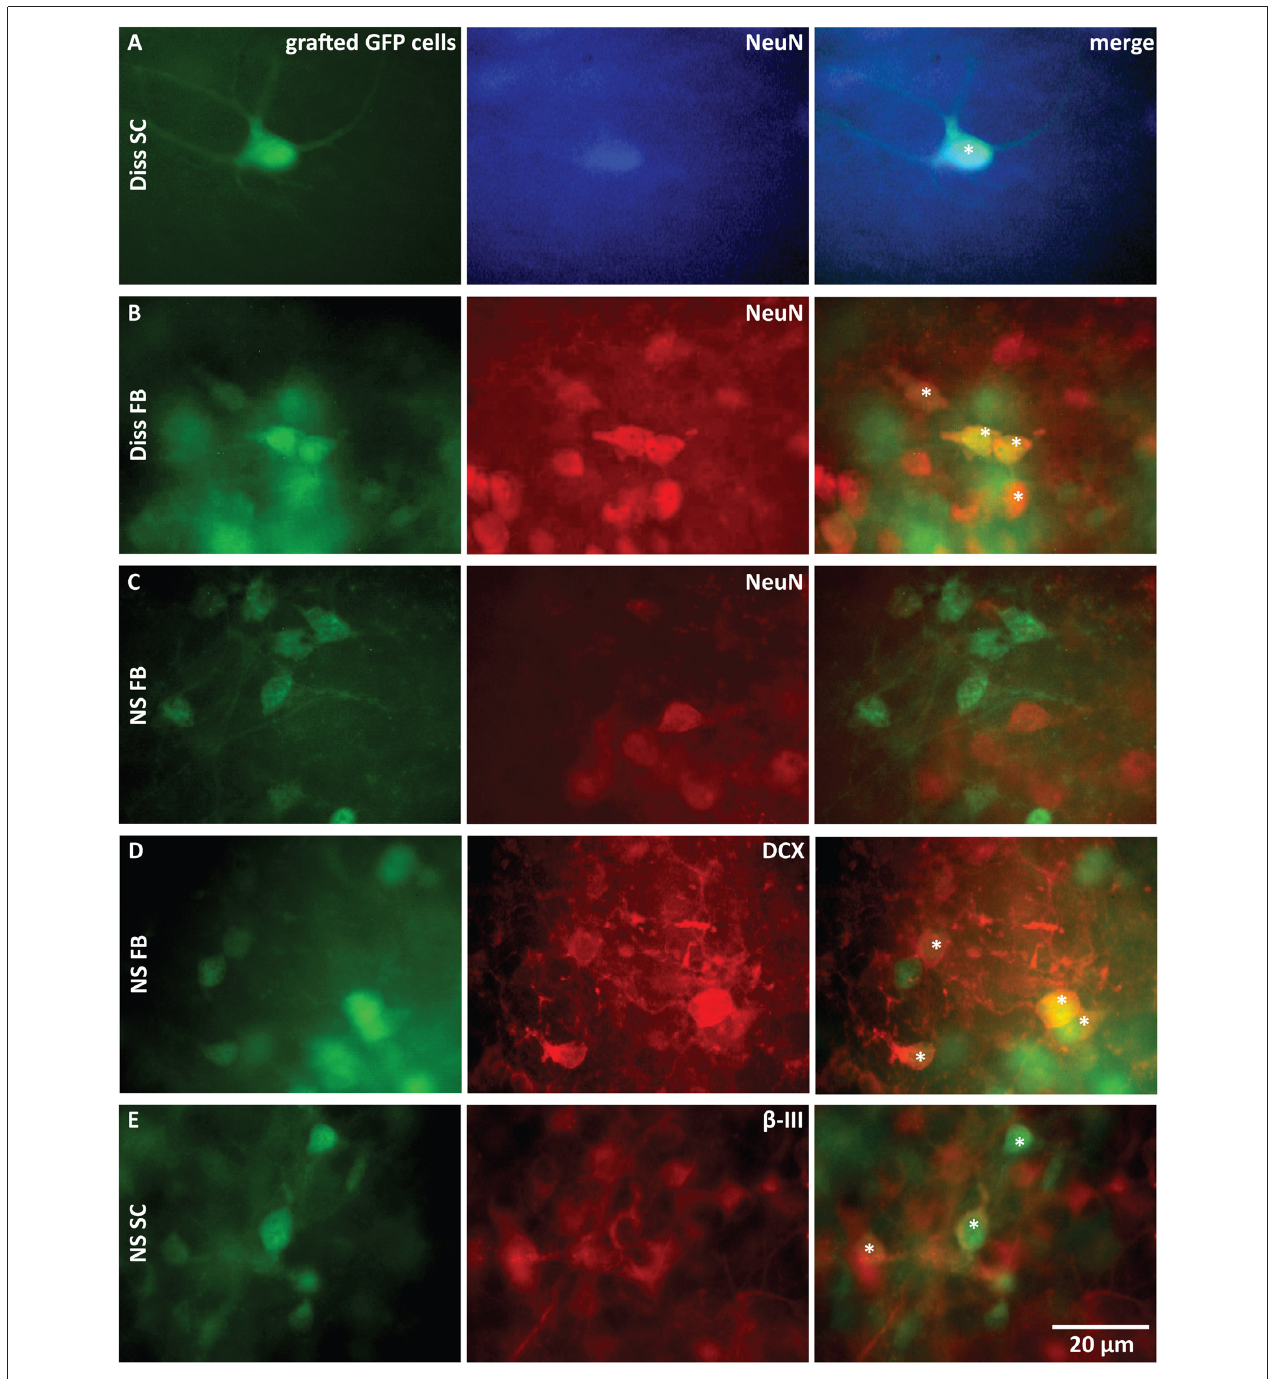
FIGURE 3 | Immunohistochemical characterization of grafted cells 3 weeks after transplantation. (A–E) Comparison of GFP stainings of transplanted cells with stainings for mature neurons (A–C) , neuroblasts (D) and postmitotic neurons (E) . Stars ( ∗ ) mark double-stained cells. Only dissociated cells (Diss) from FB and SC gave rise to mature neurons. Anti- β -III-tubulin ( β -III): postmitotic neurons, anti-Doublecortin ( DCX ): neuroblasts, anti-NeuN: mature neurons, NS, neurospheres.